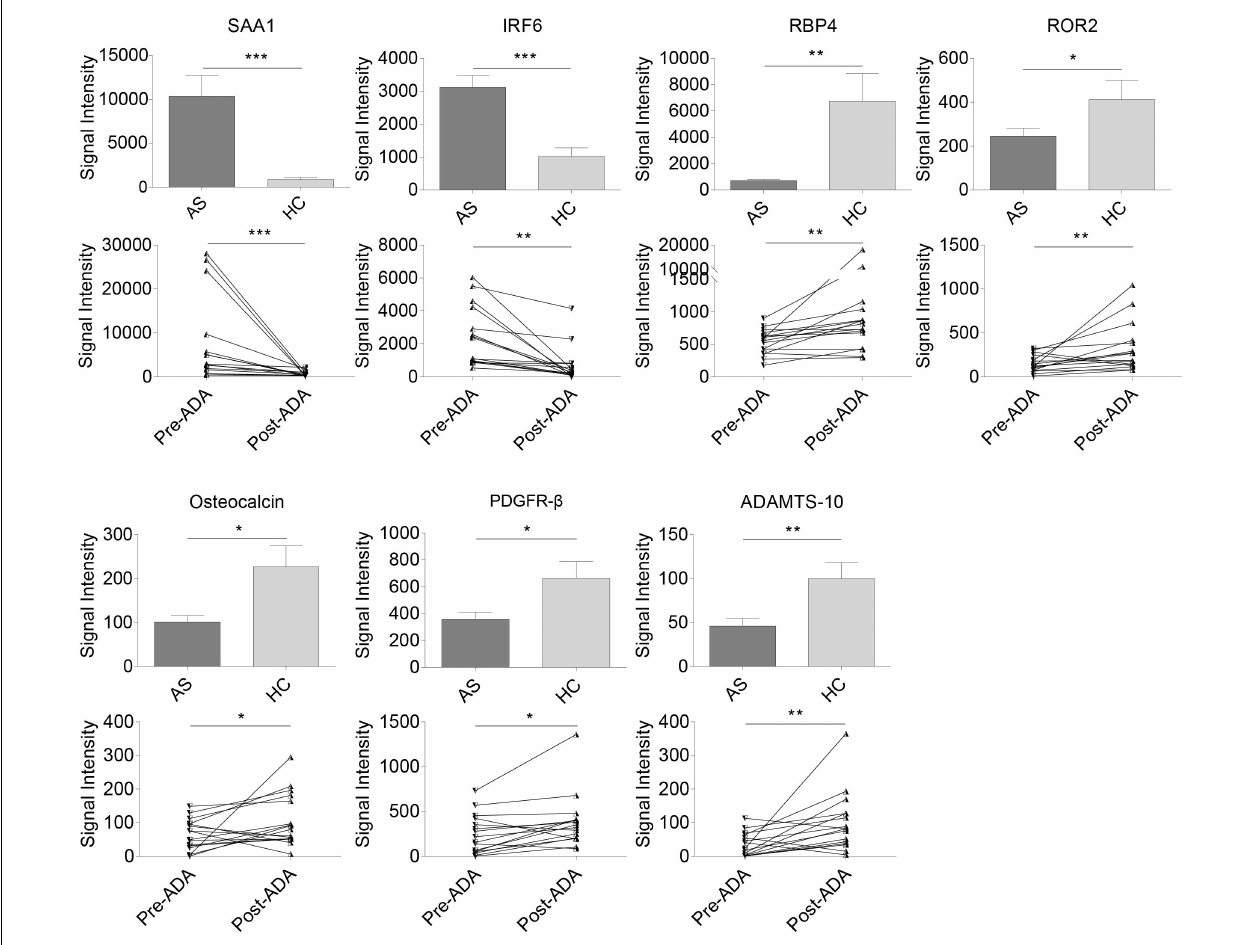
FIGURE 3 | Relative expression levels in seven pivotal DEPs among samples from all AS patients, HCs, patients pre- and post-treated with ADA in the discovery cohort. Two proteins (SAA1 and IRF6) were expressed higher in AS group and down-regulated after 24-week ADA treatment, and five proteins (RBP4, ROR2, osteocalcin, PDGFR- β , and ADAMTS-10) were expressed lower and up-regulated after ADA treatment. Data were shown as box and whisker plots (mean ± SEM) and before-after plots for pair samples. * P -value < 0.05, ** P- value < 0.01, *** P -value < 0.001. DEP, differentially expressed protein; HC, healthy control;